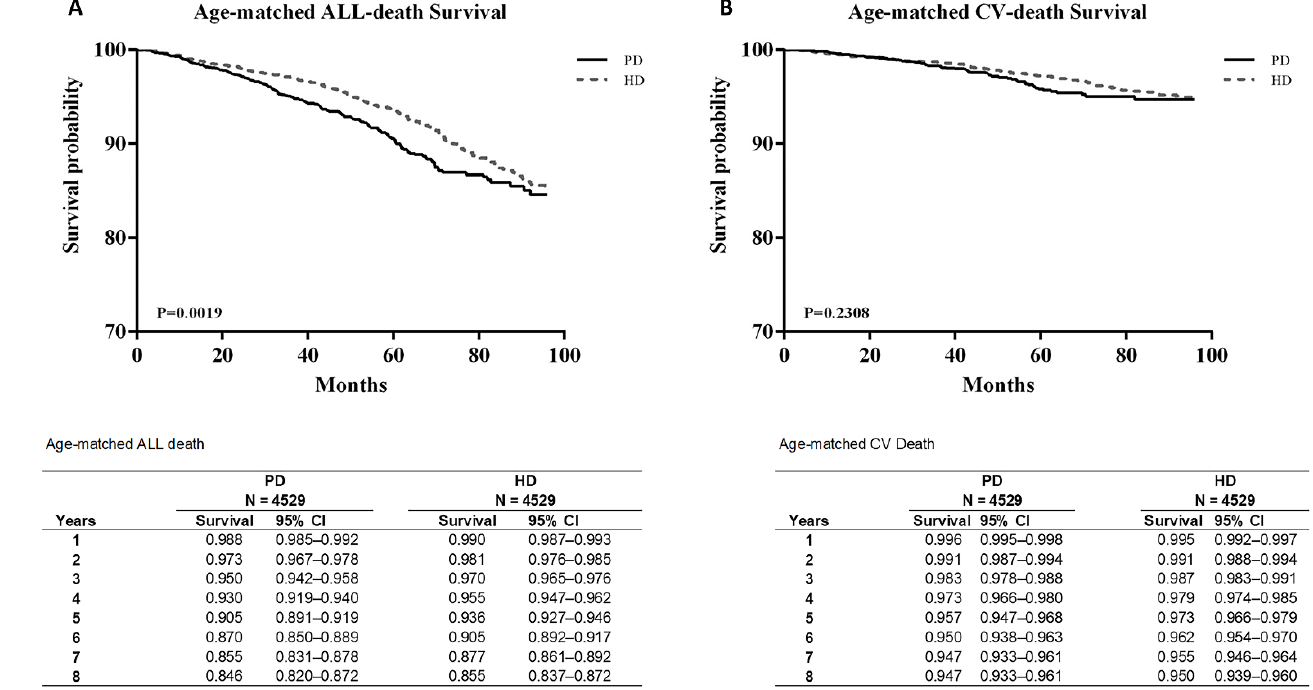
Figure 2. Survival curves between all-death survival ( A ) and CV-death survival ( B ). CV mortality was also not significantly different between the groups. After age matching, the survival probability from all-cause mortality was significantly lower in pa- tients on PD than in those on HD ( p < 0.05). However, CV mortality showed no significant difference even after age matching (Figure 3B).